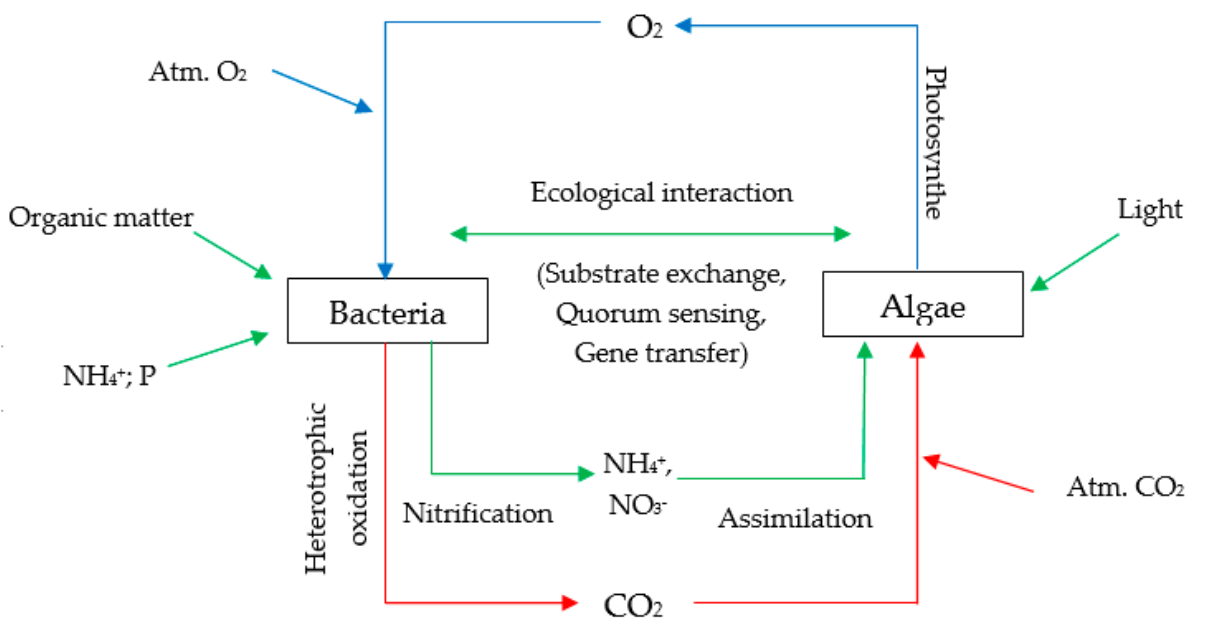
Figure 7. Symbiotic conversions occurring in microalgal-bacterial granules.